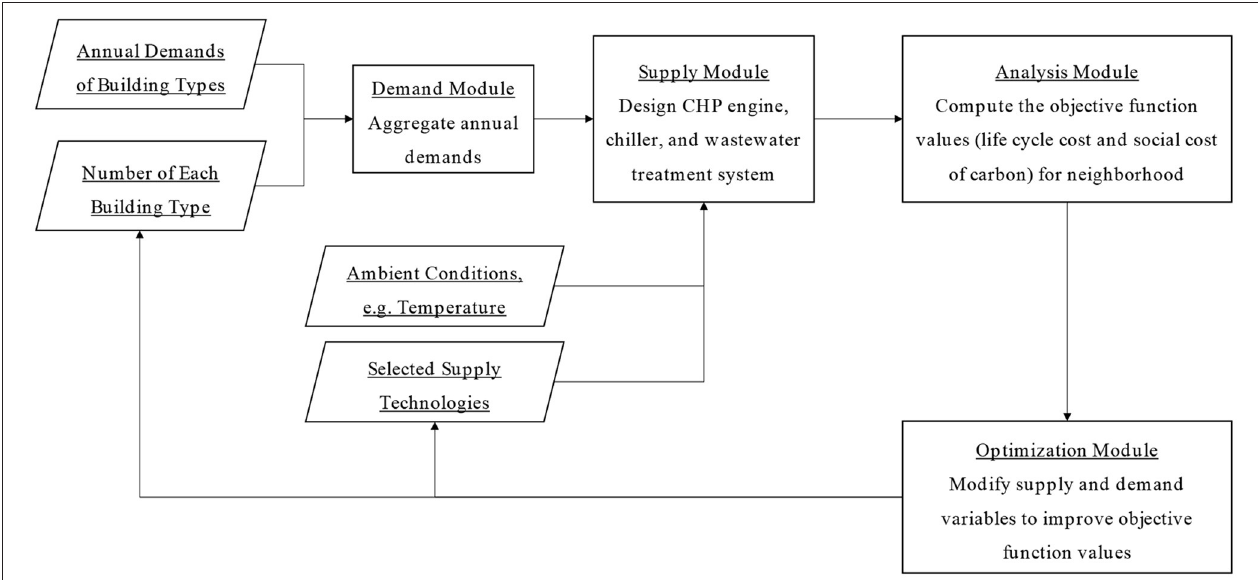
FIGURE 1 | Flow diagram of the proposed